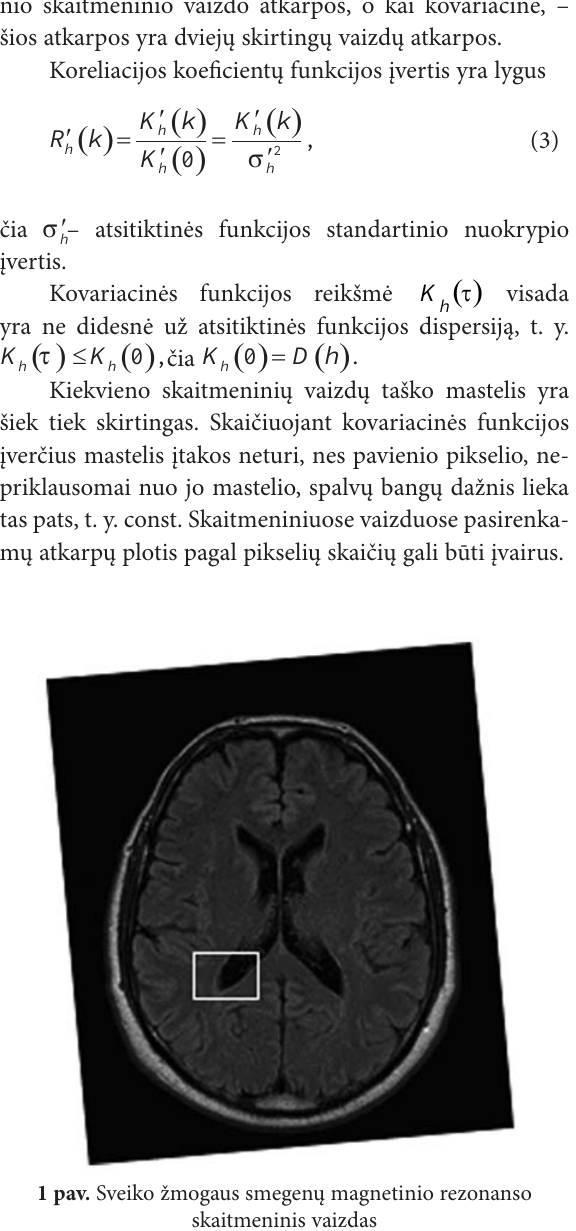
Fig. 1. Digital view of magnetic resonance of the health human Fig. 2. Digital view of magnetic resonance of the